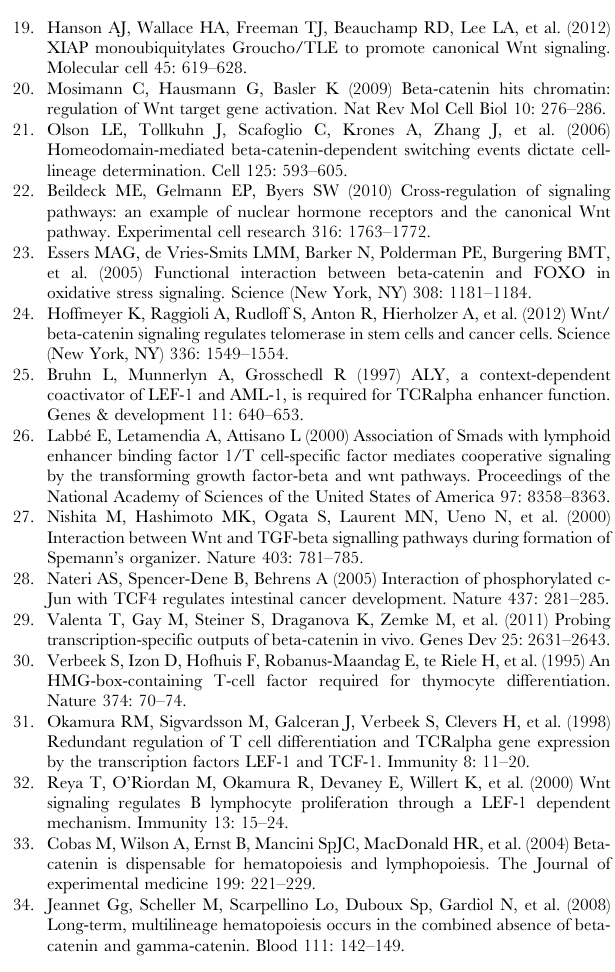
TCF1 constructs was assessed by immunoblot using the same cell lysates (upper panel). (B) 293T cells were co-transfected with SuperTop reporter, pRL-CMV and b -catenin (S33Y) with or without the indicated TCF1 constructs, followed two days later by luciferase assay. Figure S6 ATF2 synergizes with TCF1mt independently of b - catenin. 293T cells were co-transfected with TCF1mt, ATF2 or Wnt3a in combination with shRNA vectors targeting either CHK1 (control), the three Dvl isoforms or b -catenin, in the presence of the SuperTop reporter and the renilla plasmid pRL- CMV. Three days after transfection, luciferase assay was performed and TCF/LEF activity expressed as the mean + / 2 SD of the renilla normalized luciferase values. The Wnt3a construct was used to assess the efficiency of shDvl and sh b - catenin in inhibiting Wnt canonical signaling. Figure S7 Lack of synergy between TCF4 and ATF2 factors. (A) 293T cells were co-transfected with TCF4, ATF2, CREB5 or ATF7 as indicated, in the presence of the SuperTop reporter and the renilla plasmid pRL-CMV. Two days after transfection, luciferase assay was performed and TCF/LEF activity expressed as the mean + / 2 SD of the renilla normalized luciferase values (lower panel). The same lysate was used to assess the expression of TCF4 and ATF2 factors by immunoblot (upper panel). (B) 293T cells were co-